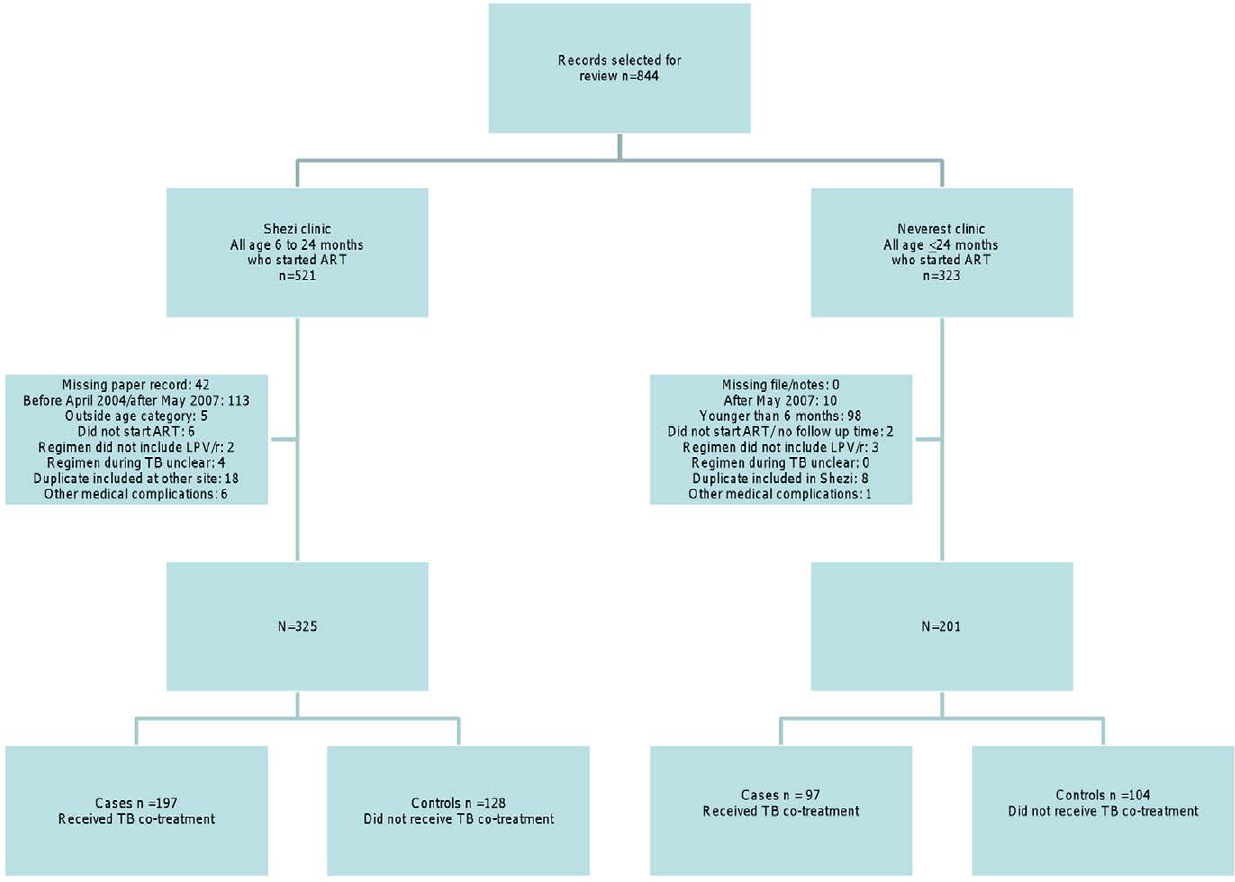
Figure 1. Flow diagram of study participants.